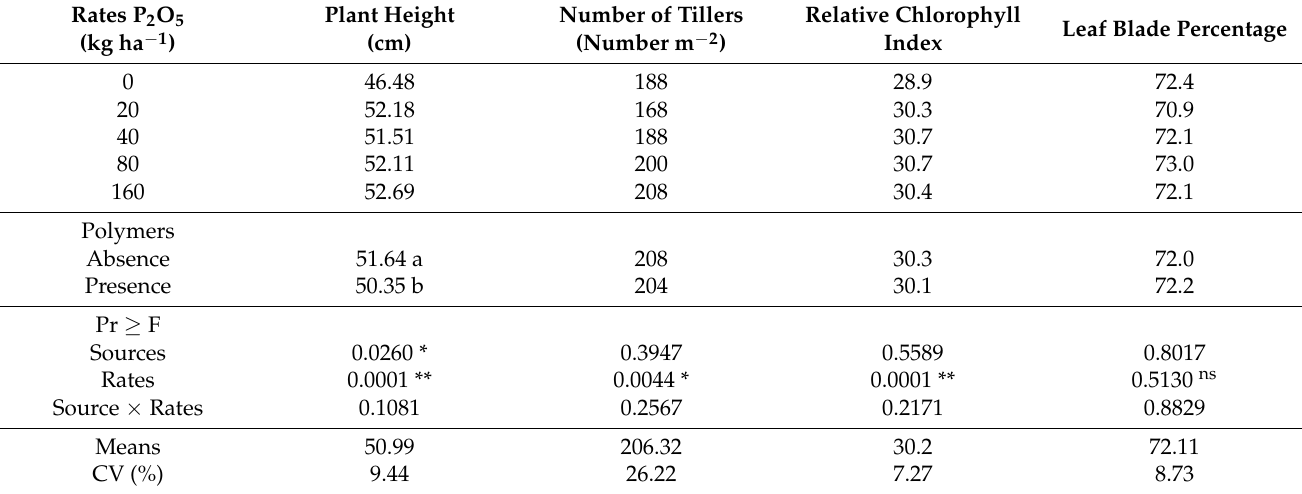
Table 3. Mean plant height, number of tillers per square meter, relative chlorophyll index and leaf blade percentage of Mavuno grass for different phosphorus sources and rates in the presence and absence of polymers in dystrophic